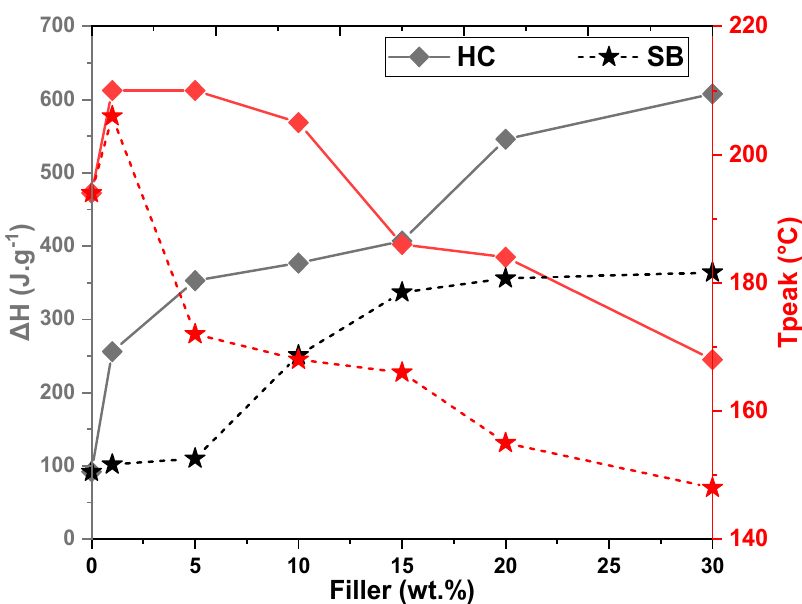
Figure 2. Evolution of the enthalpy of reaction ( ∆ H ; black line) and the maximum temperature of reaction ( T peak ; red line) as a function of filler ratio.